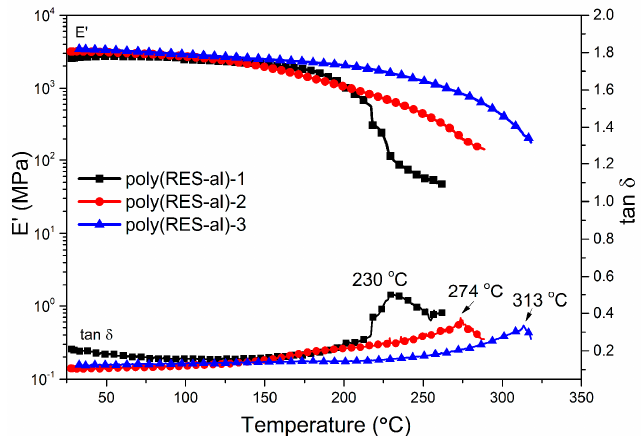
Figure 7. Dynamic mechanical spectra of polybenzoxazines.